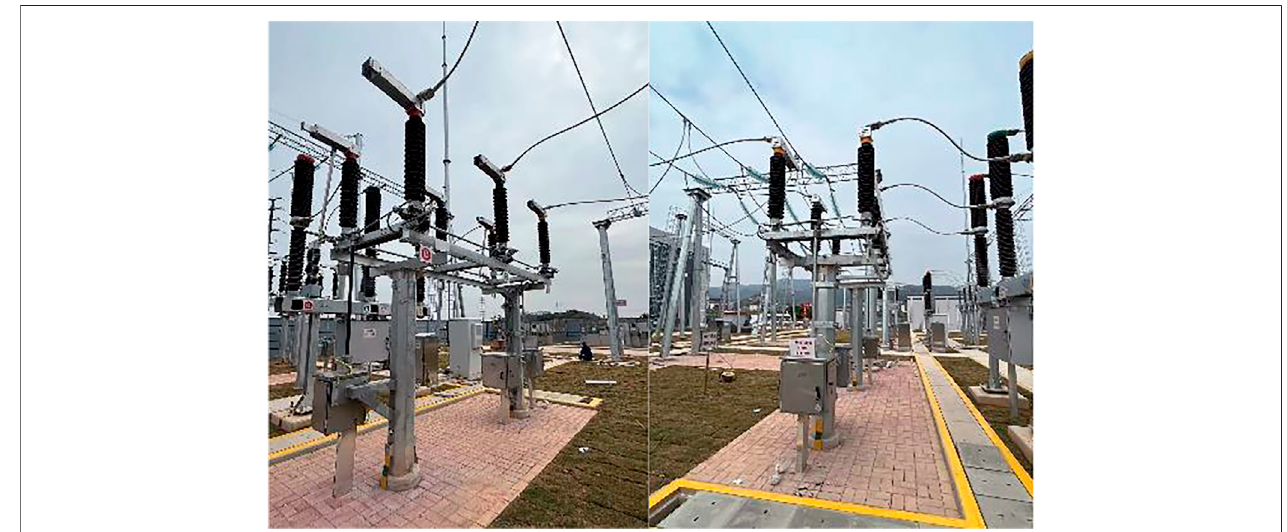
FIGURE 12 | Site map of Yunfu 110 kV Fenghuang phase II